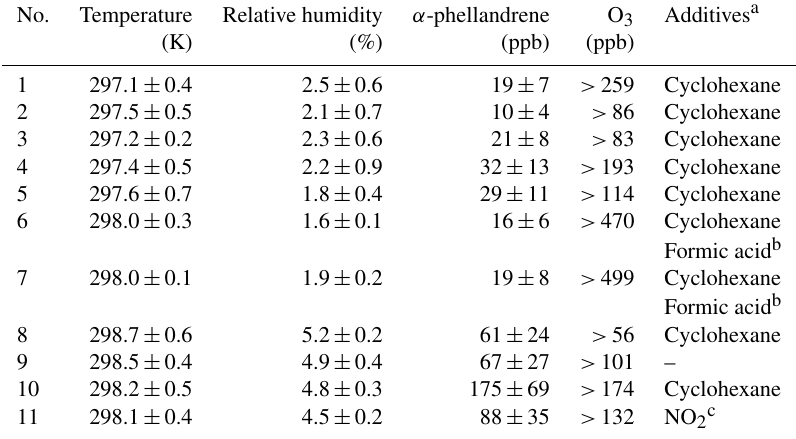
static classifier (TSI 3080) fitted with a TSI 3081 differential mobility analyser (DMA) and condensation particle counter (CPC, TSI 3775). Sheath and aerosol flow rates were 3.0 and 0.3 Lmin − 1 , respectively, with voltage inside the DMA var- ied exponentially from − 10 to − 9950 V every 240 s to pro- vide a mobility spectrum over particle diameters 14–750